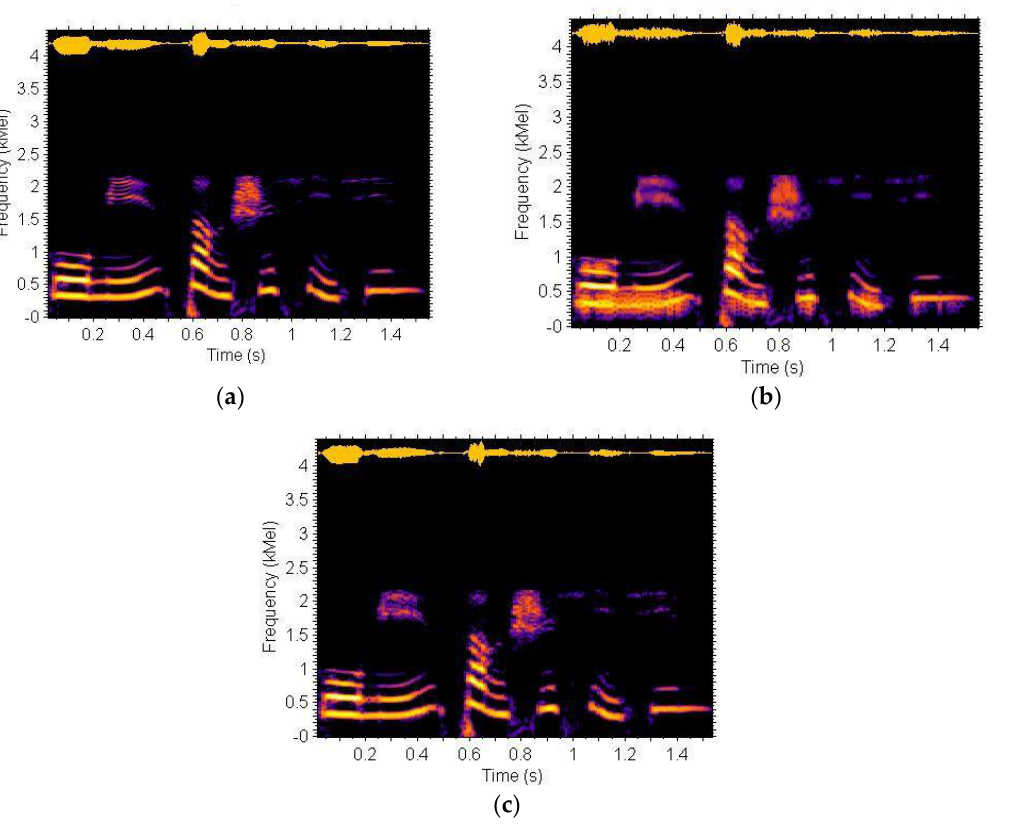
Figure 3. Comparison of the spectrograms of two algorithm: ( a ) original speech; ( b ) L2 algorithm; ( c ) proposed algorithm.